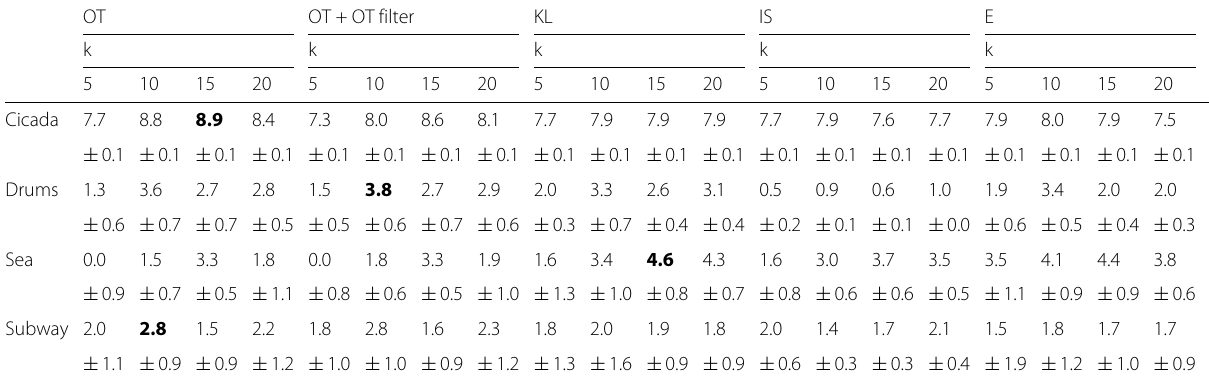
Table 1 Speech denoising SDR scores